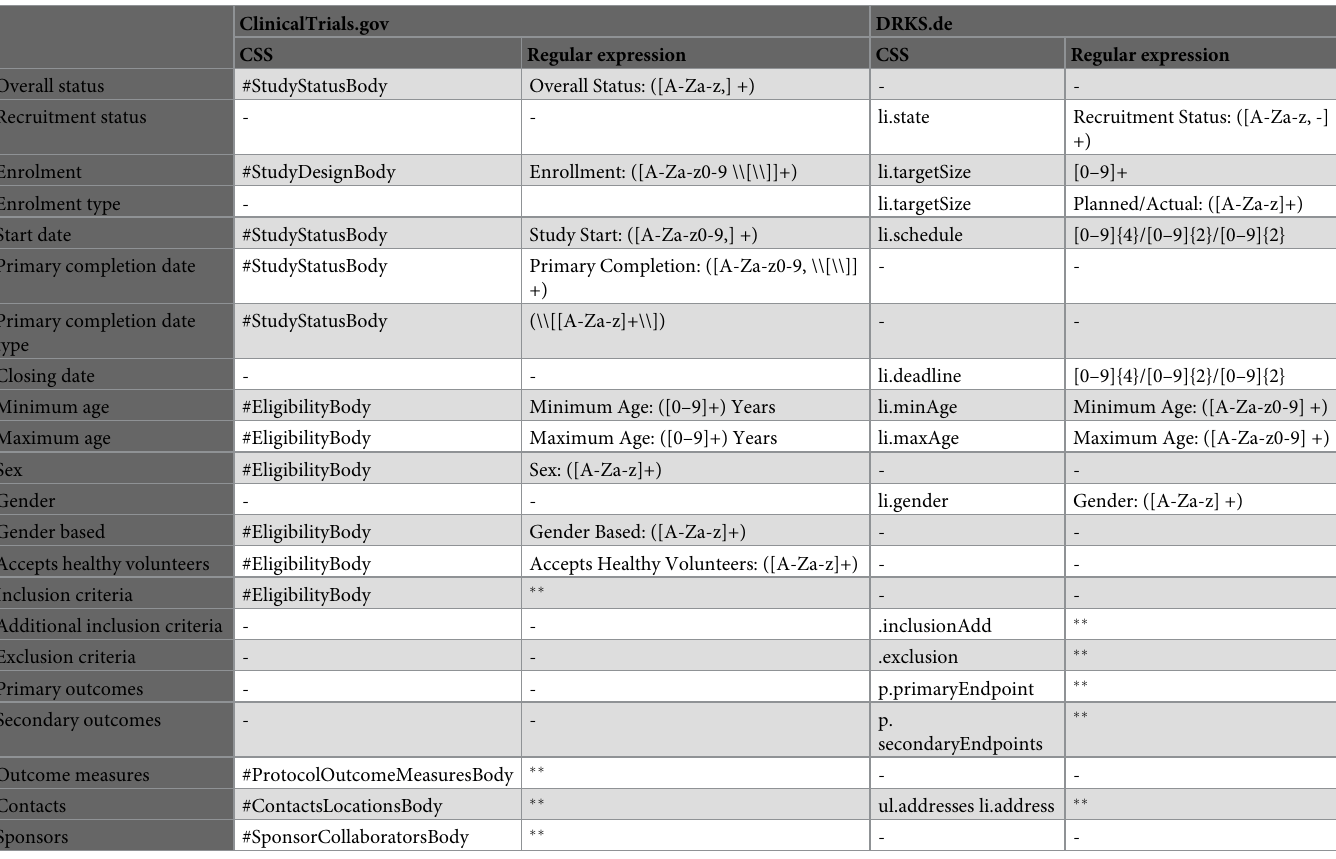
Asterisks ( �� ) indicate table data parsed and encoded as JSON rather than extracted using simple regular expressions. A single hyphen (-) indicates that this data point is not available to be downloaded for this clinical trial